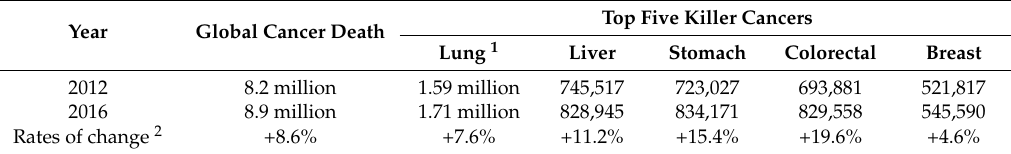
Table 1. Estimated cancer deaths worldwide and top five killer cancers for both sexes combined, 2012 (International Agency for Research on Cancer (IARC) data) and 2016 (Institute for Health Metrics and Evaluation (IHME)